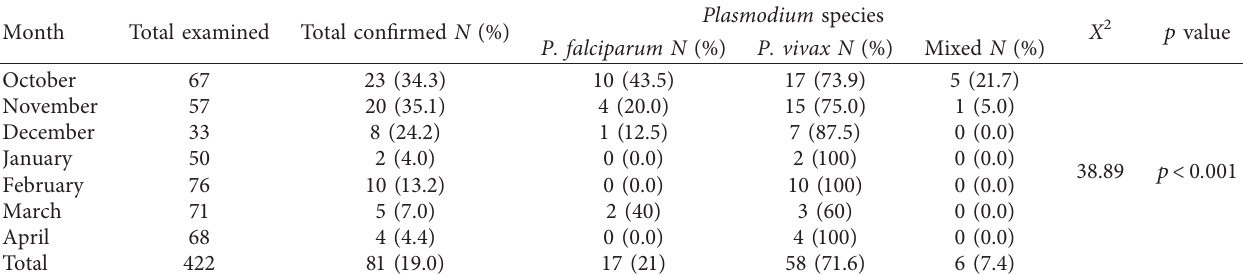
Table 2: Seasonal patterns and prevalence of plasmodium species in Shewa Robit, Ethiopia ( n �